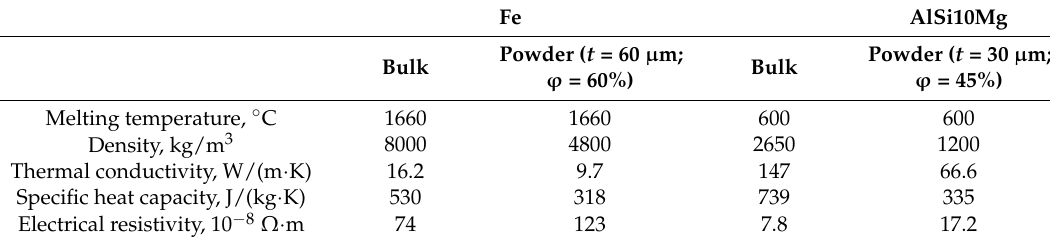
Table 5. Physical properties of Fe [3] and AlSi10Mg [20] powders used for melt pool modeling.